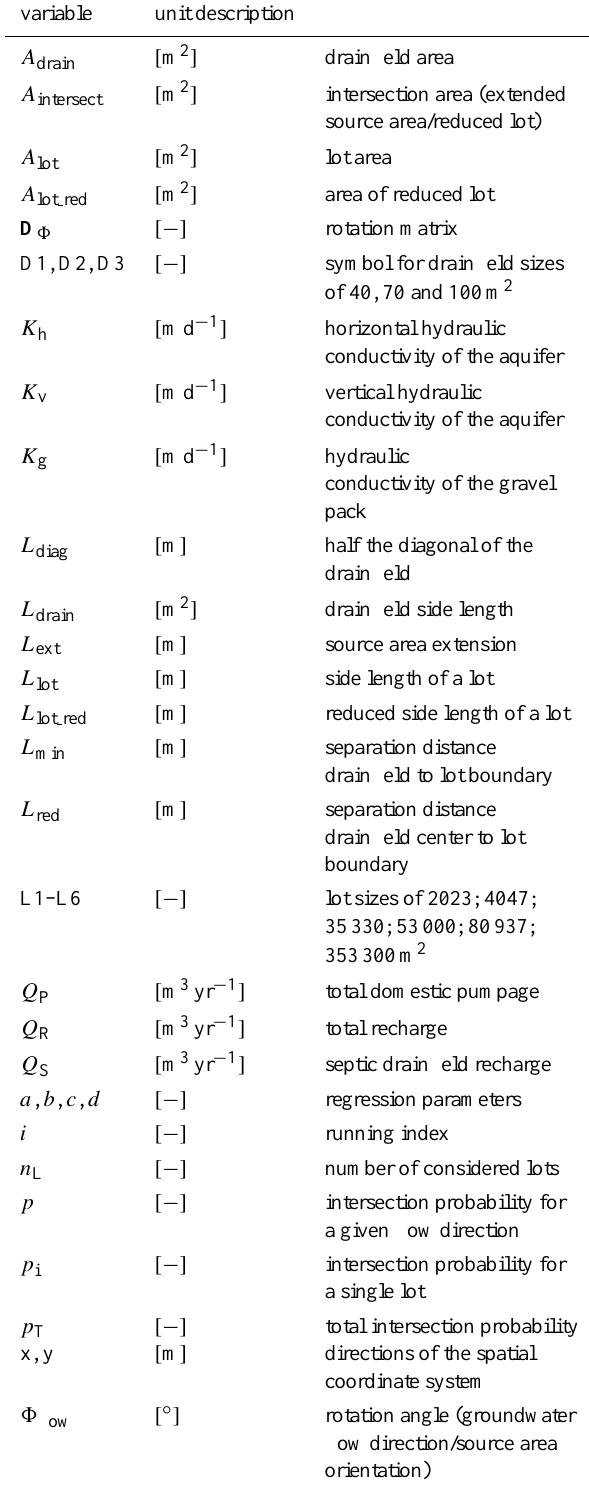
Table A1. List of variables, parameters and symbols